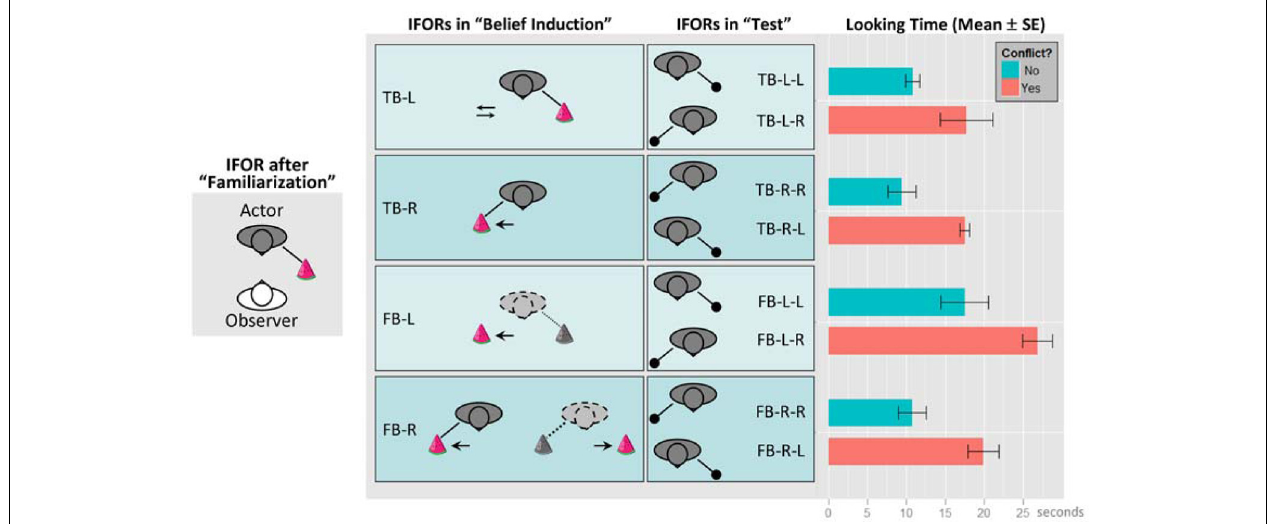
the “TB-R” condition, the toy was moved from the actor’s left to her right in her presence. In the “FB-L” condition, the toy was last seen by the actor at her left but was moved to her right in her absence. In the “FB-R” condition, the toy was moved from the actor’s left to her right in her presence but moved back to her left in her absence. In test phase (3), infants watched the actor reaching one of the locations for the toy and their average looking times were recorded and analyzed. Here we use triadic labels to represent each test condition, with the first two parts repeating the label for the corresponding belief induction condition, and the last part representing the direction where the actor reached for the toy. The equality between the last two parts represents whether there is a conflict between the IFOR representation at the end of the belief induction phase and the one in the test phase. For example, “TB-L-L” represents the condition in which the actor held a true belief that the toy was at her left-hand side and she actually reached the same location for the toy (“no conflict”); In comparison, “TB-L-R” represents the condition in which the actor held a true belief that the toy was at her left-hand side but she actually reached her right-hand side for the toy (“conflict”). Infants’ looking times (mean and standard errors in seconds) in each test condition are shown on the rightmost